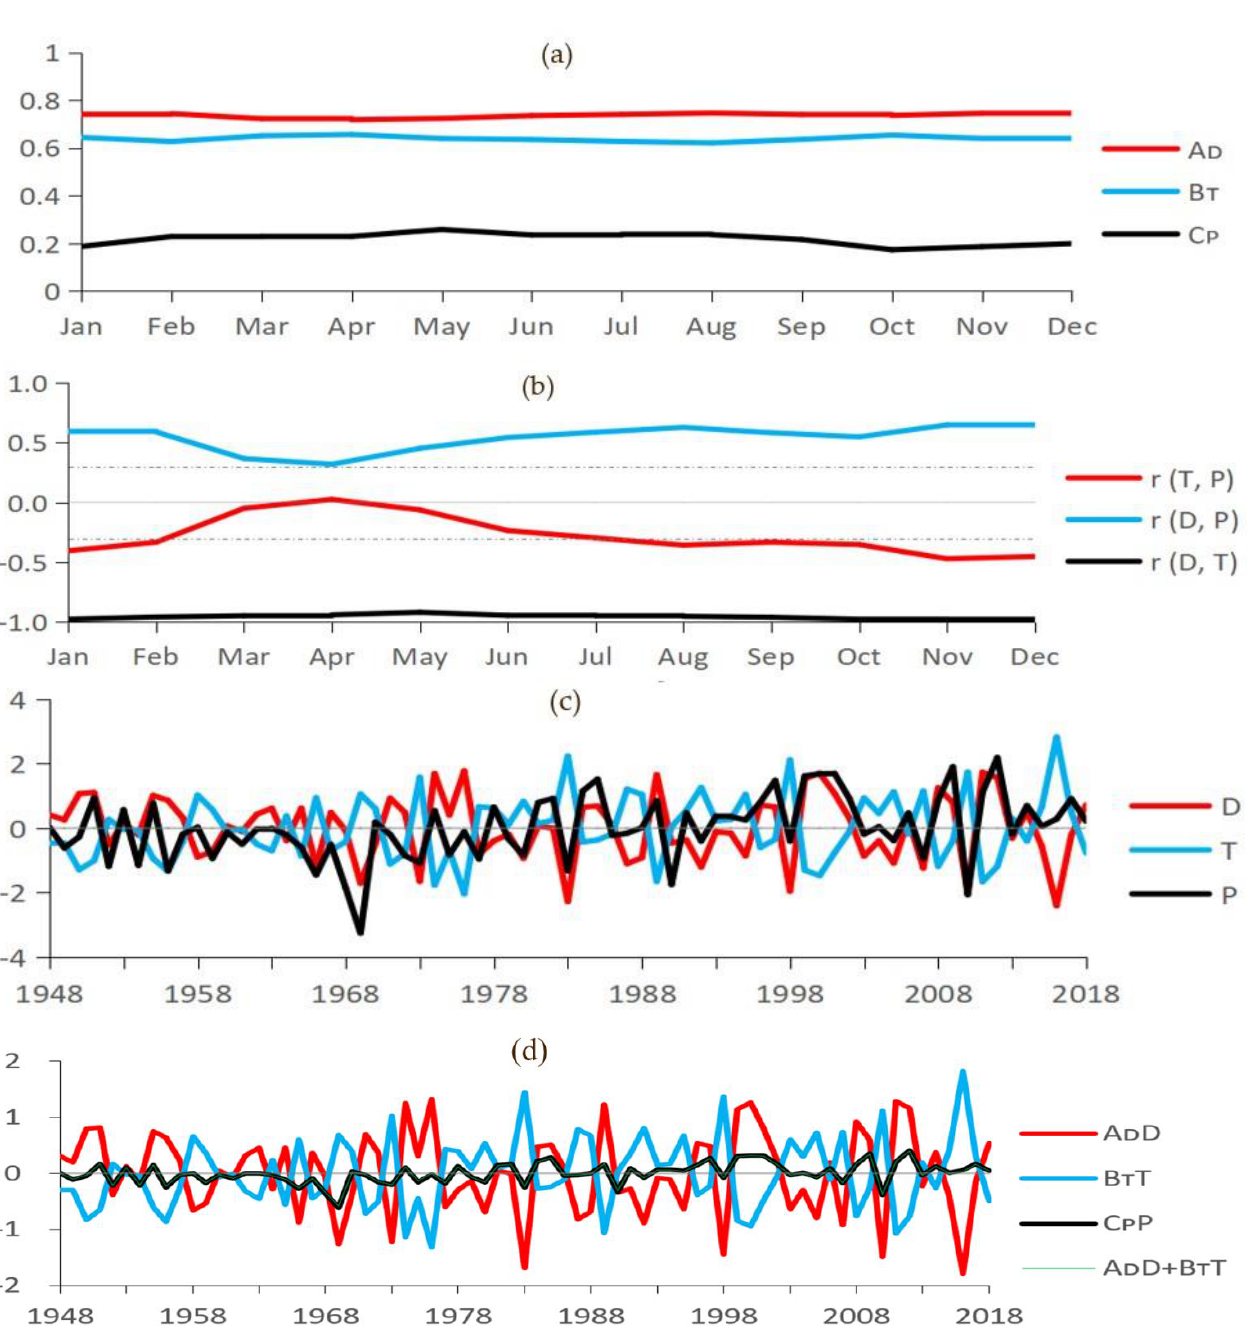
Figure 5. ( a ) The coefficients A D , B T , and C P obtained for each month; ( b ) the correlation coefficients (r) between each pair of the normalized quantities (with the chain lines indicating the significance level of 0.01); ( c ) the year–to–year variations of the three normalized quantities D , T , and P for January; and ( d ) the corresponding variations of the A D D , B T T , C P P , as well as the A D D + B T T . The curve for A D D + B T T (green) overlies it for C P P (black). The data of pressure and temperature used for the calculations are averaged over the region selected in Figure 4.